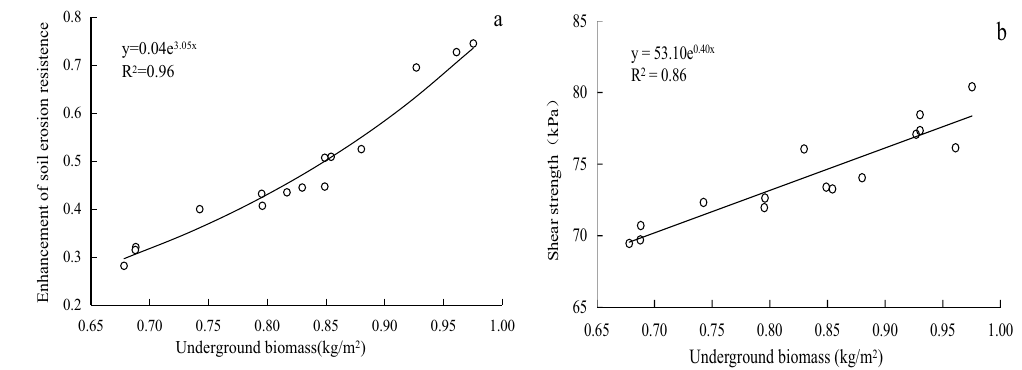
Figure 4. Relationship between slope protection performance and the belowground biomass of E.